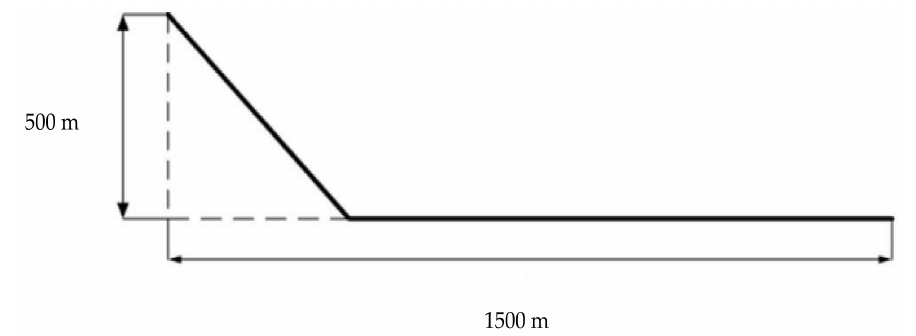
Figure 11. Diagram of the mine filling